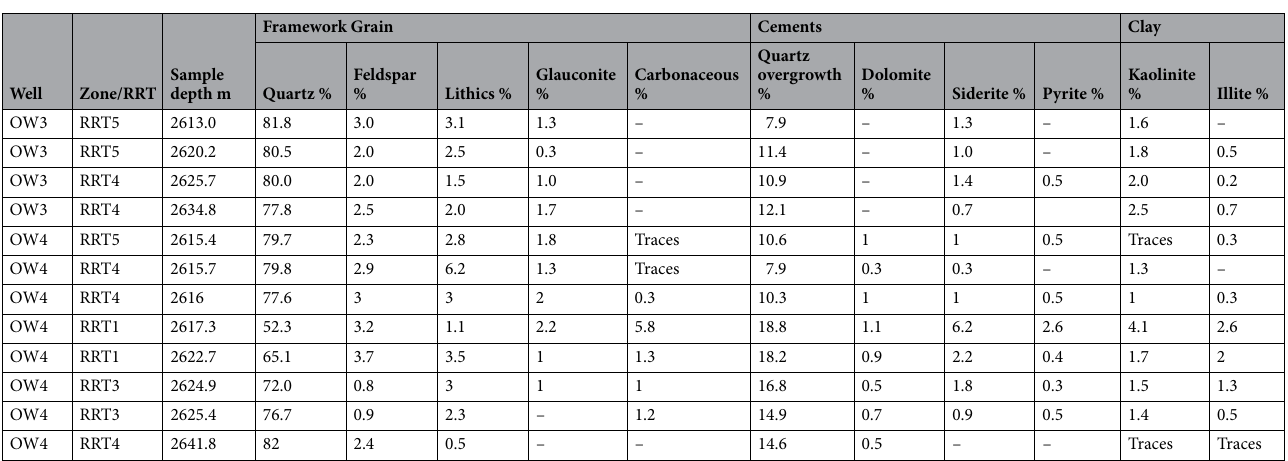
Table 3. Result of quantitative mineralogical analysis of wells OW3 and OW4 indicating the dominant cement and clay that affects flow